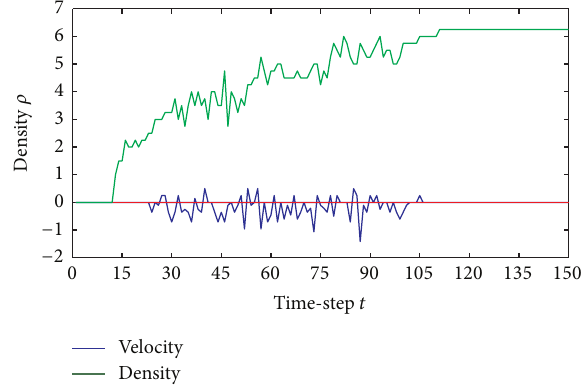
Figure 8: Velocity-time relation and density-time relation of simu- lation for the